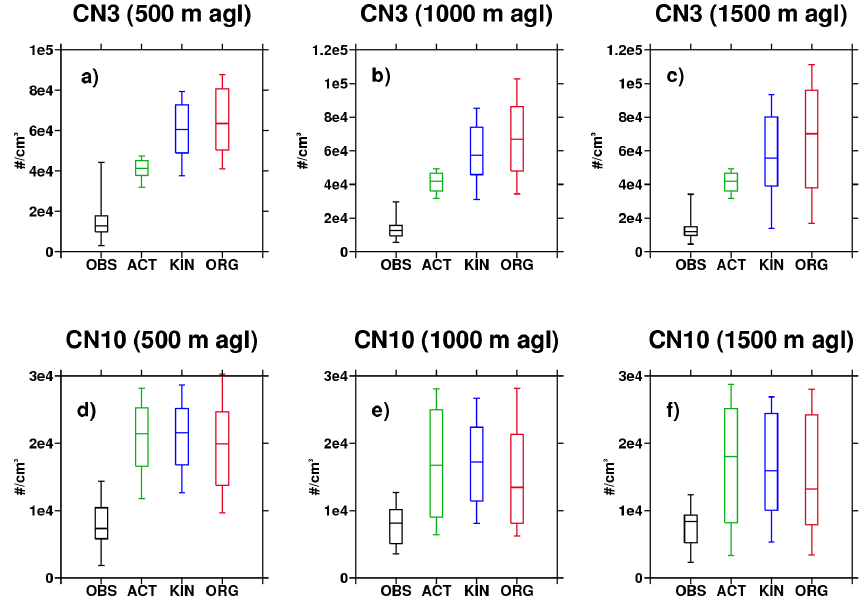
Figure 19. Same as Fig. 18, except for the 12 June 2010 afternoon G-1